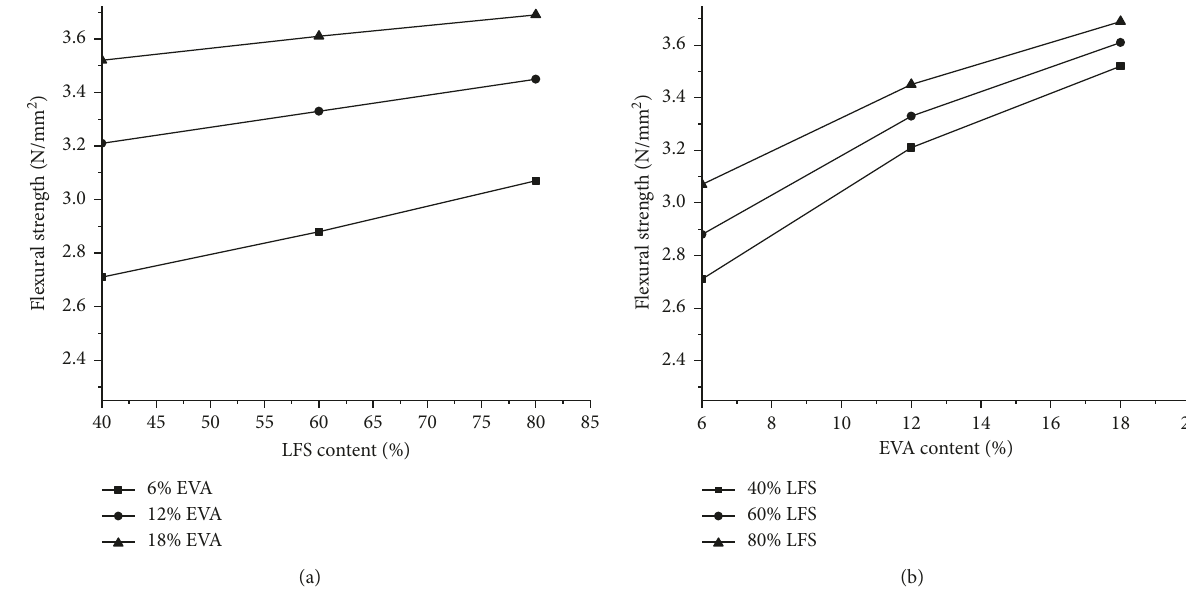
Figure 6: Comparative analysis of flexural strength at a fixed rate of (a) EVA inclusion and (b) LFS